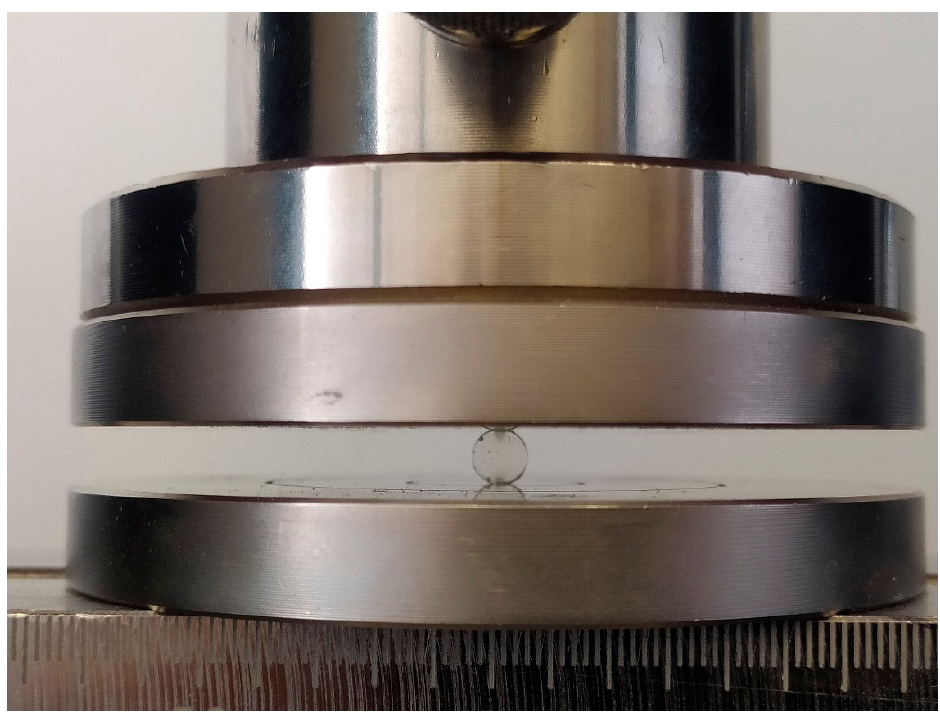
Figure A2. Diametral tensile strength test.